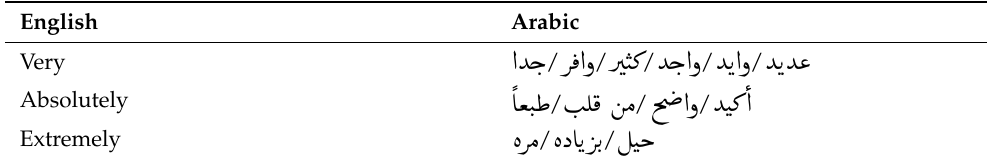
Table 5. Samples of intensifier